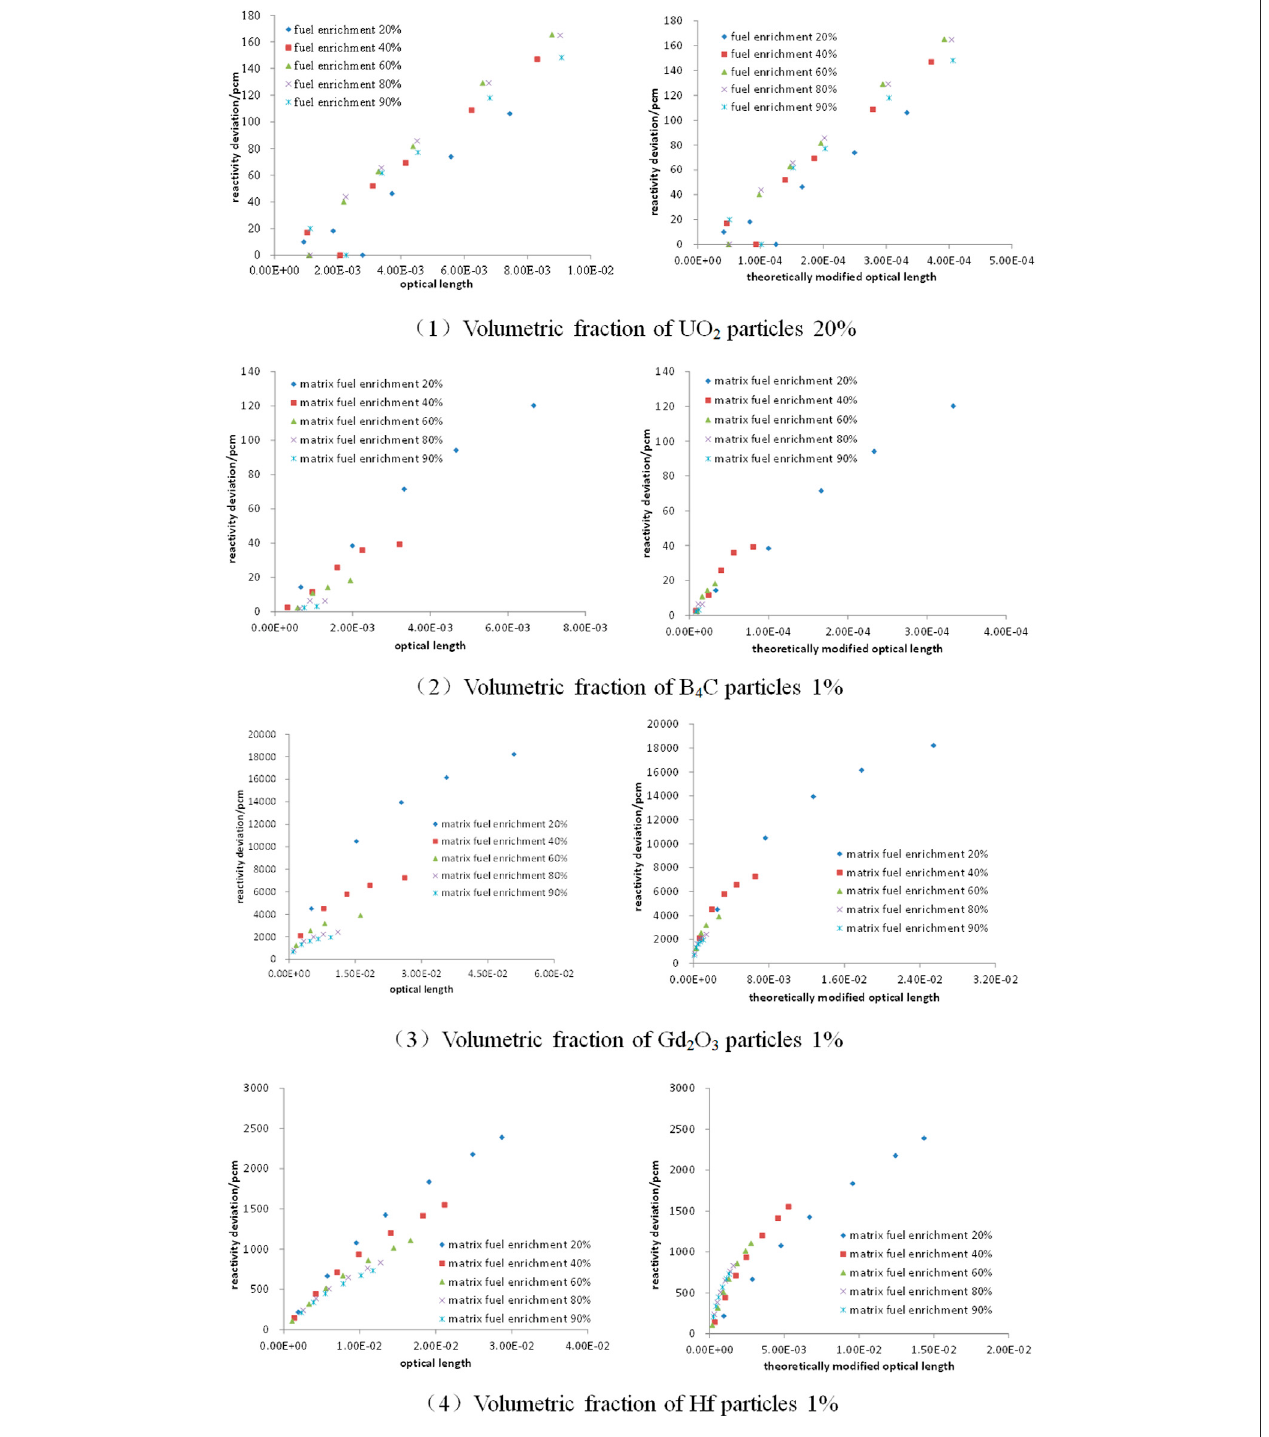
FIGURE 4 | Relationship between reactivity deviation and optical length or theoretically modi fi ed optical length under different fuel enrichment of matrix.